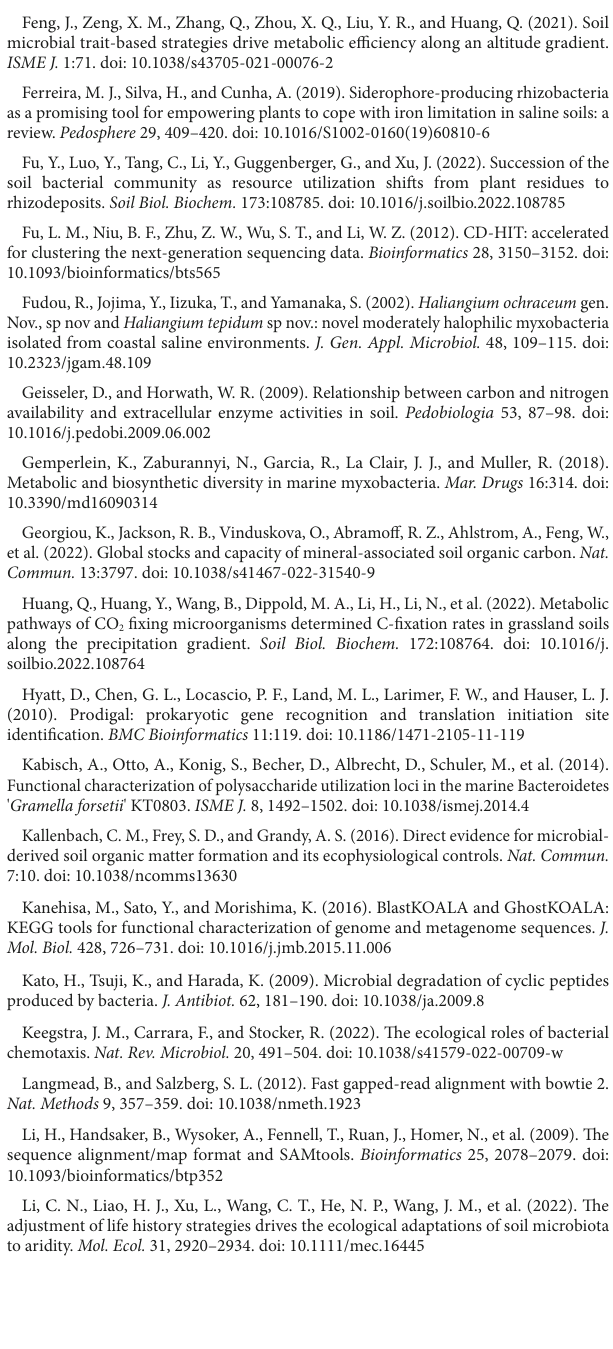
SUPPLEMENTARY FIGURE S1 Soil specific enzyme activities per unit of microbial biomass (mg product g − 1 MBC) in day 7 ( A-C ) and day 56 ( D-F ). Different letters indicate significant differences ( P < 0.05). HSC, high-salinity soil added with 13C-glucose; HSCNP, high-salinity soil added with 13C-glucose and NP nutrients; LSC, low-salinity